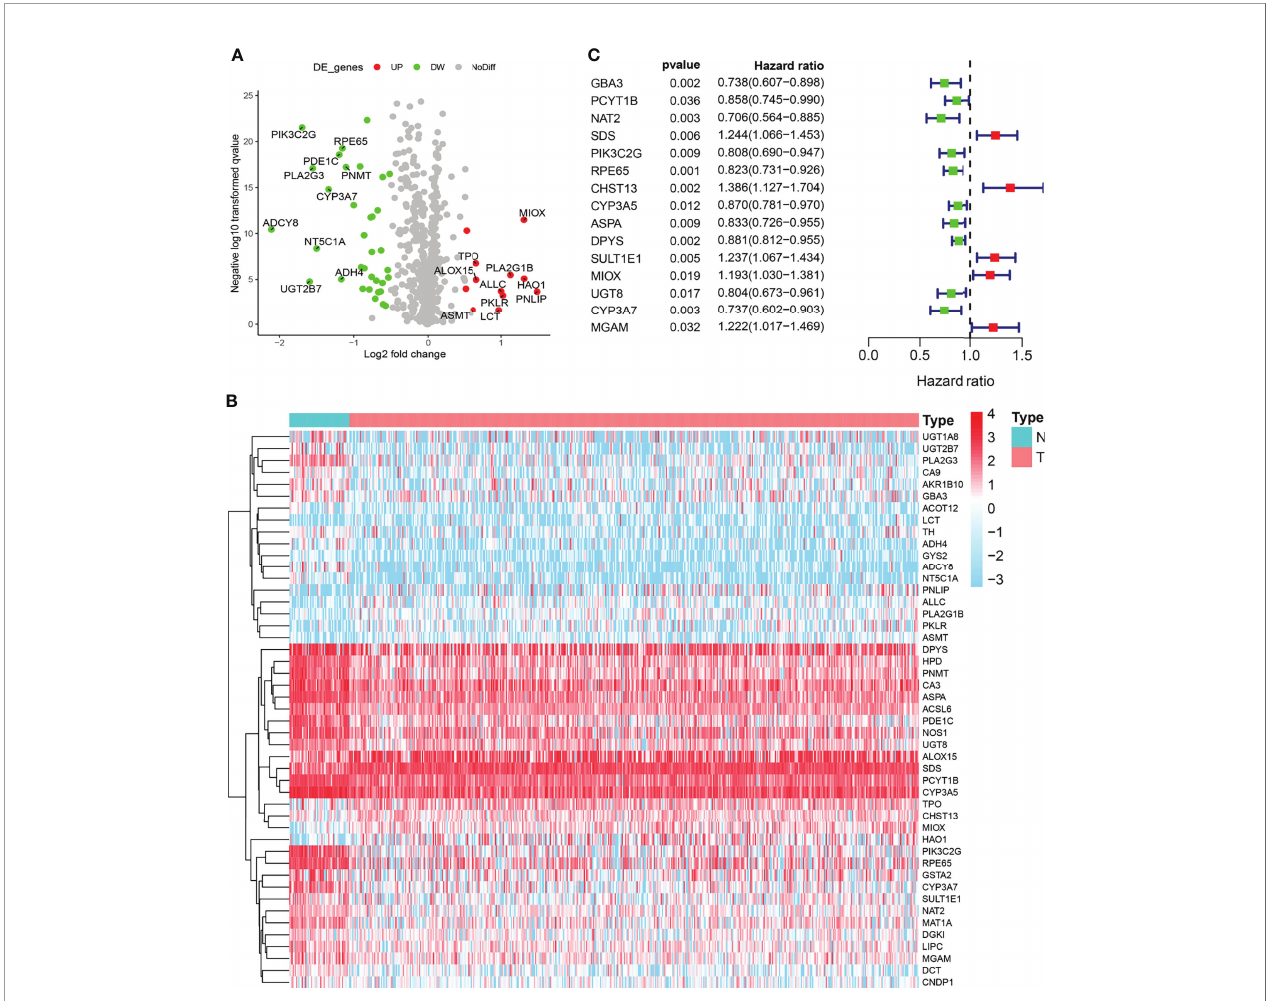
FIGURE 1 | Identi fi cation of metabolic differentially expressed genes (MDEGs) in both The Cancer Genome Atlas (TCGA) cohorts. (A) Identi fi cation of signi fi cant MDEGs from 133 metabolic genes. (B) Hierarchical partitioning of signi fi cant MDEGs was acquired from DNA microarrays based on TCGA cohort. (C) Univariate Cox regression analysis of 46 signi fi cant MDEGs (p < 0.05) in TCGA cohort was performed in a forest